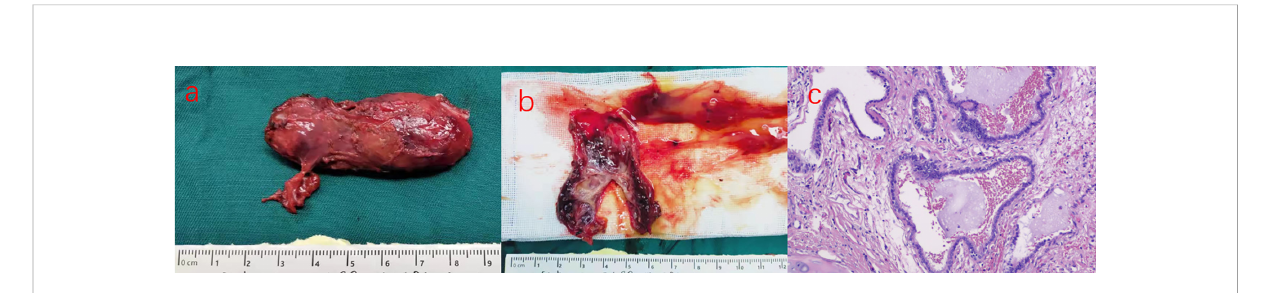
FIGURE 2 (A) An ovoid, well-de fi ned, and homogeneous cystic lesion. (B) Mucous fi lled the cystic lesion. (C) Histopathologic section revealed the cyst lined with tall columnar epithelium and cyst wall containing thin smooth muscle bundles, seromucous glands, and mature hyaline cartilage. (Haematoxylin and eosin stain, original magni fi cation,